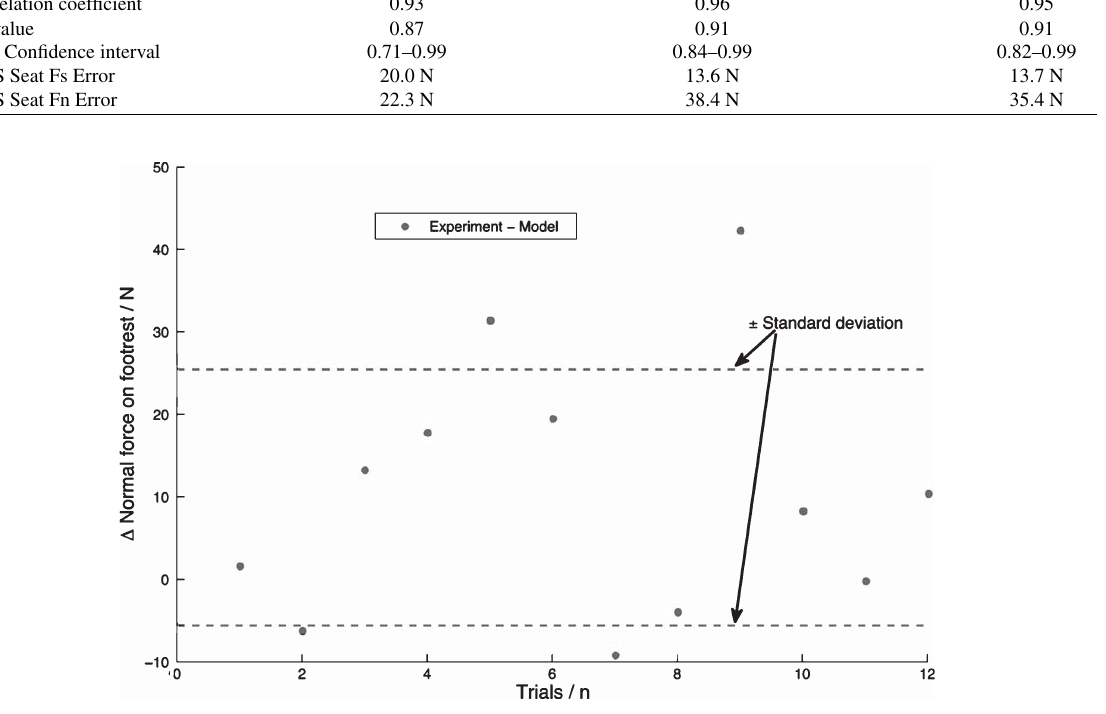
Fig.5. Thedifferencebetweenthemeasuredandpredictednormalforceonthefootrest.Thedifferentdatapointsareforthedifferentexperiments where the height of the footrest was